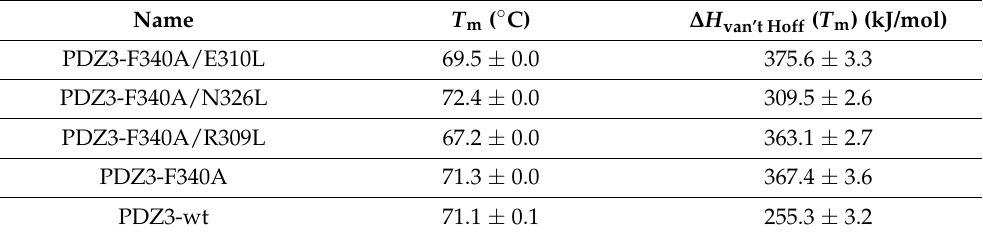
The parameters were calculated by fitting the CD denaturation curves using a two-state model in Origin 2020b software. CD denaturation curves were measured at 0.5 mg/mL, pH 7.5, 25–90 ◦ C and +1.0 ◦ C/min scan